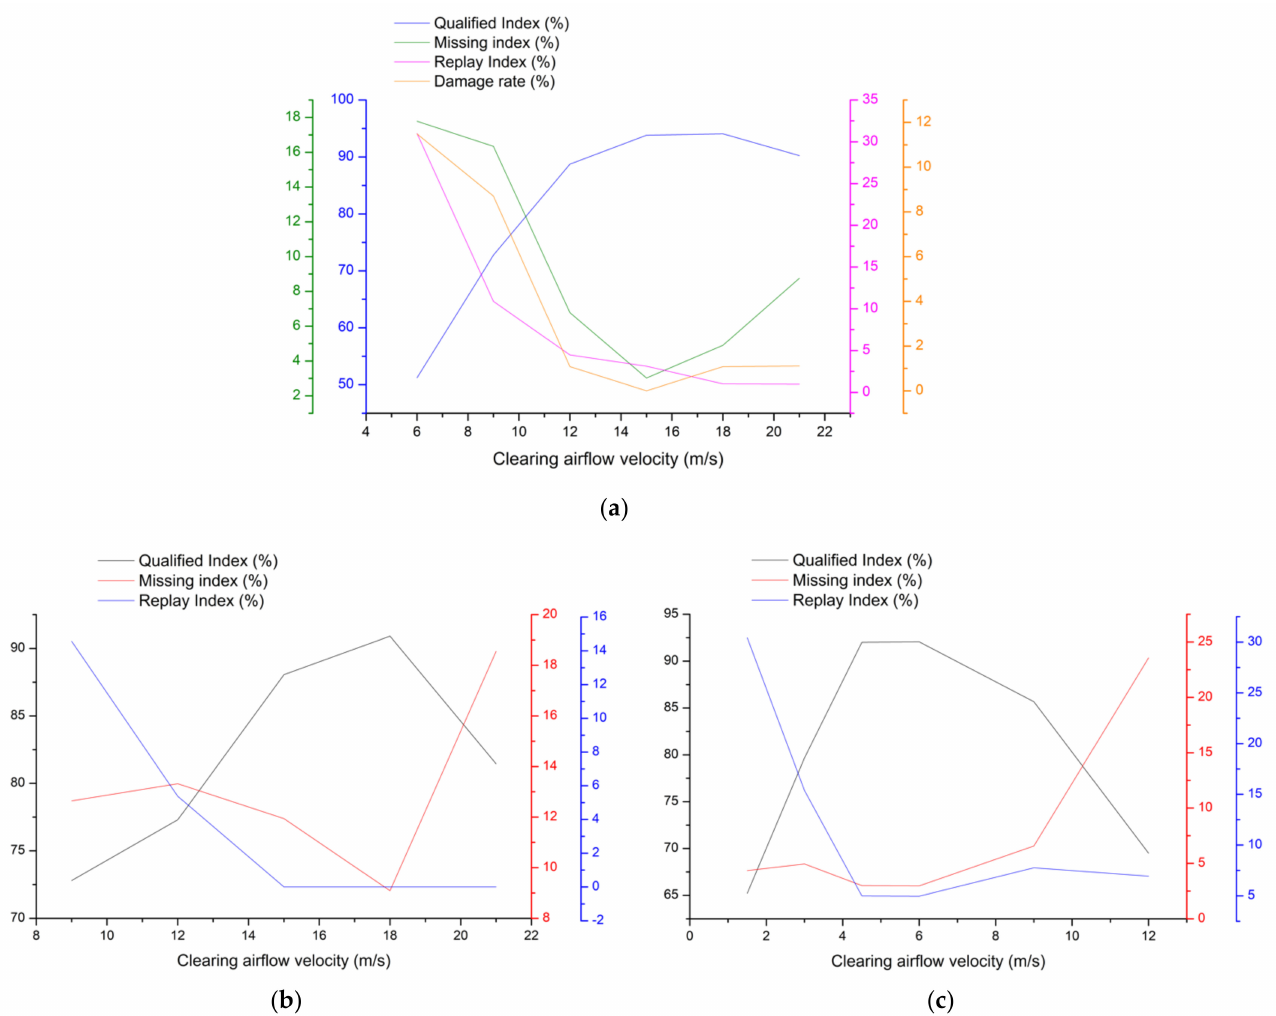
Figure 7. The relation curve between seed cleaning airflow velocity and seed performance ( a ) Soybean; ( b ) Corn; ( c )